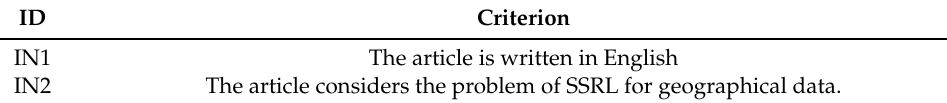
Table 1. Inclusion criteria.